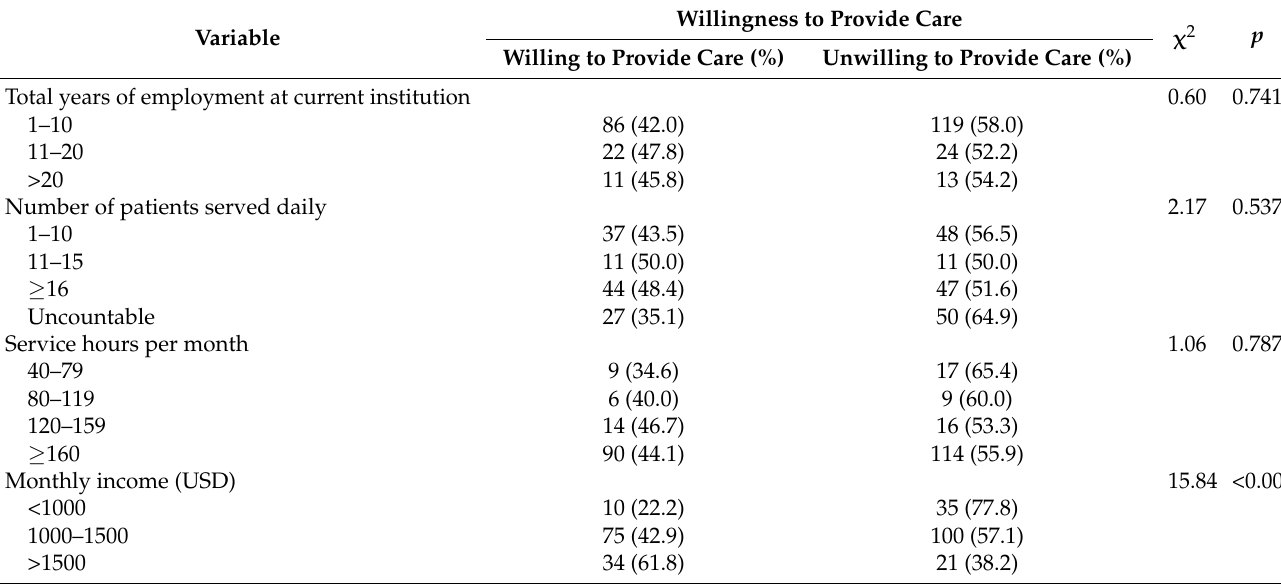
Table 3. Univariate analysis of job characteristics and willingness to provide care for patients to COVID-19 ( n = 275; continued).